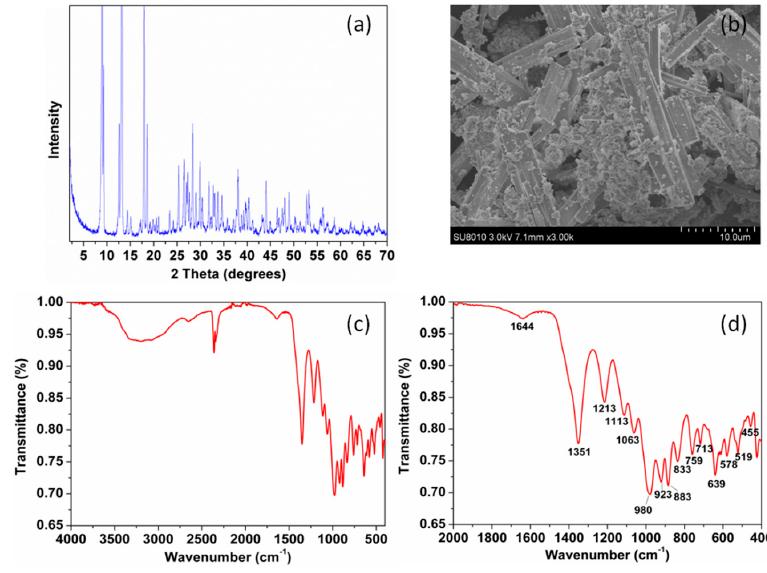
Figure 3. ( a ) XRD patterns, ( b ) SEM images, ( c ) FT-IR spectrum, and ( d ) enlarged FT-IR spectrum of zinc borate.